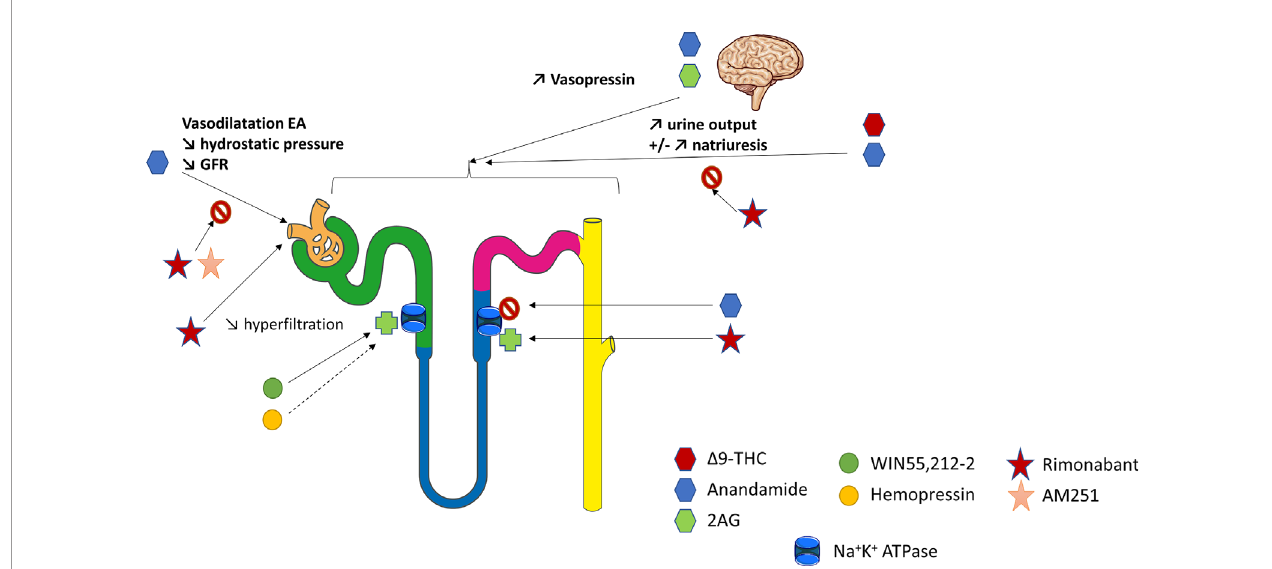
FIGURE 2 | The physiological role of CB1R within the kidney. Overview of the current knowledge of the role of CB1R in renal vasculature, tubular cells and blood pressure regulation. The fi gure has taken intp account both in vitro and in vivo experiments. 2AG, 2-arachidonoyl-glycerol; EA, efferent arterioles; GFR, glomerular fi ltration rate; THC,